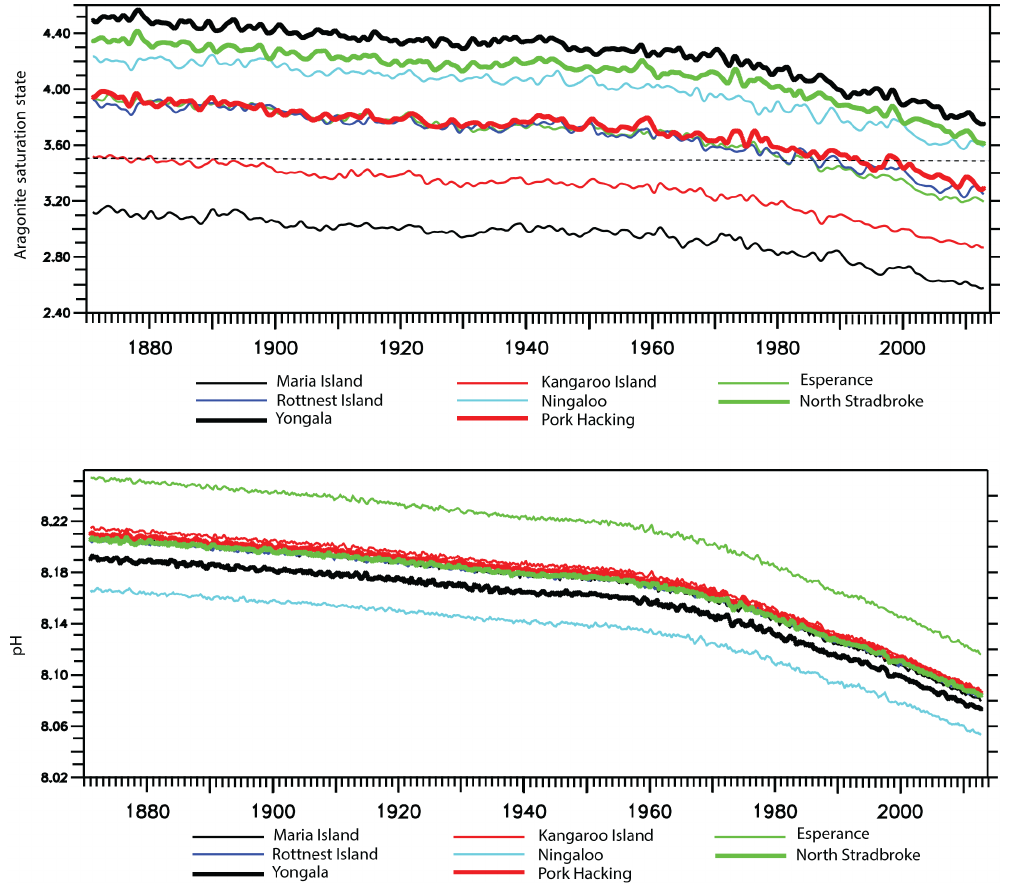
Figure 9. Reconstructed time series of the annual mean aragonite saturation state (upper) and pH (lower) at the IMOS-NRSs. Overlain on the upper plot is the threshold for the transition to marginal conditions for coral reefs (3.5) from Guinotte et al.